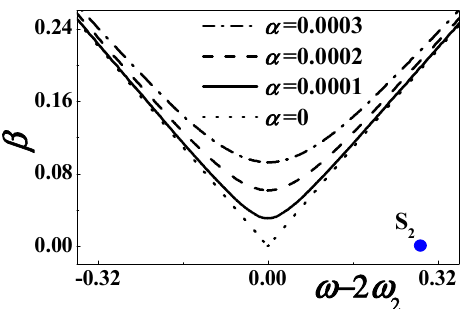
Figure 10. The stability boundary when ω ≈ 2 ω 2.